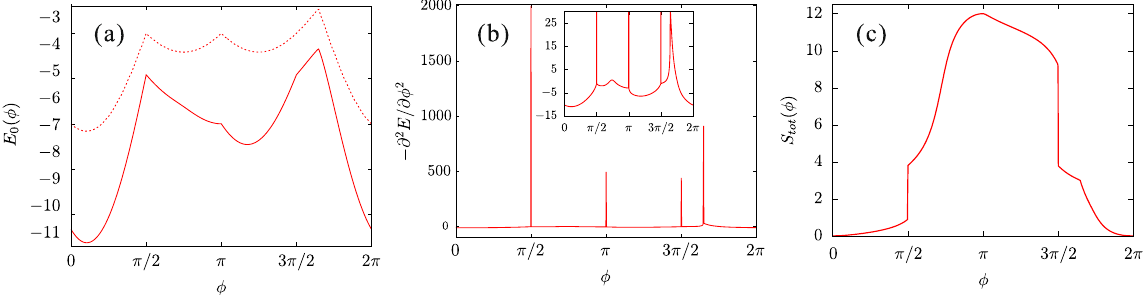
Figure 2. ( a ) Ground-state energy E 0 , ( b ) the second derivative of E 0 with respect to φ , and ( c ) total spin S tot as a function of φ , obtaind with a 24-site periodic Kitaev-Heisenberg chain. Dotted line in ( a ) indicates ground-state energy for the dimer-type charge ordering.